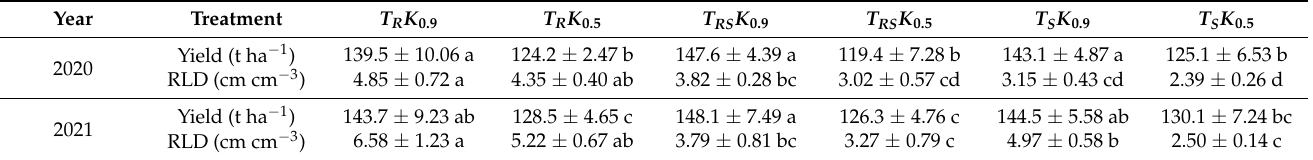
Table 6. RLD and yield under different treatments in 2020 and